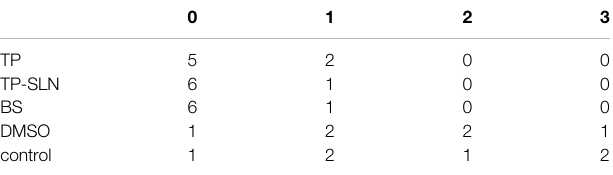
TABLE 5| Pathologicalresults ofbone destruction ofthekneejointineach group.